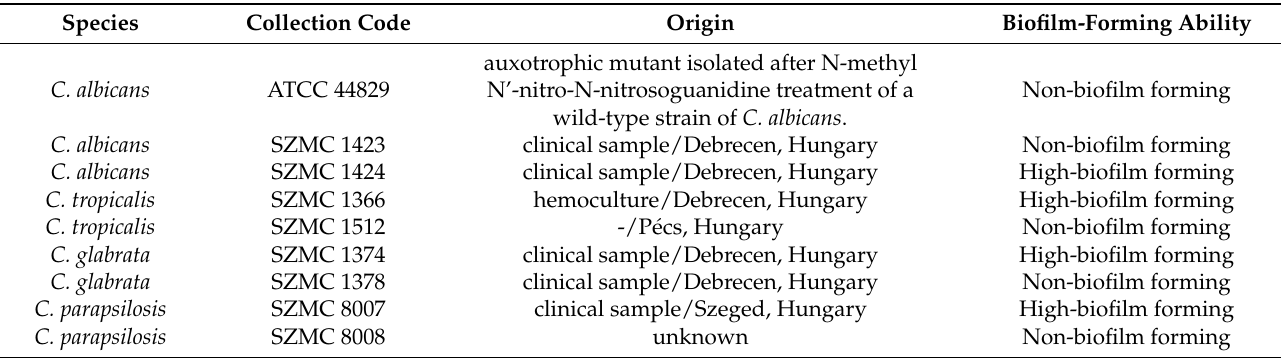
Table 2. Candida species and strains used in the